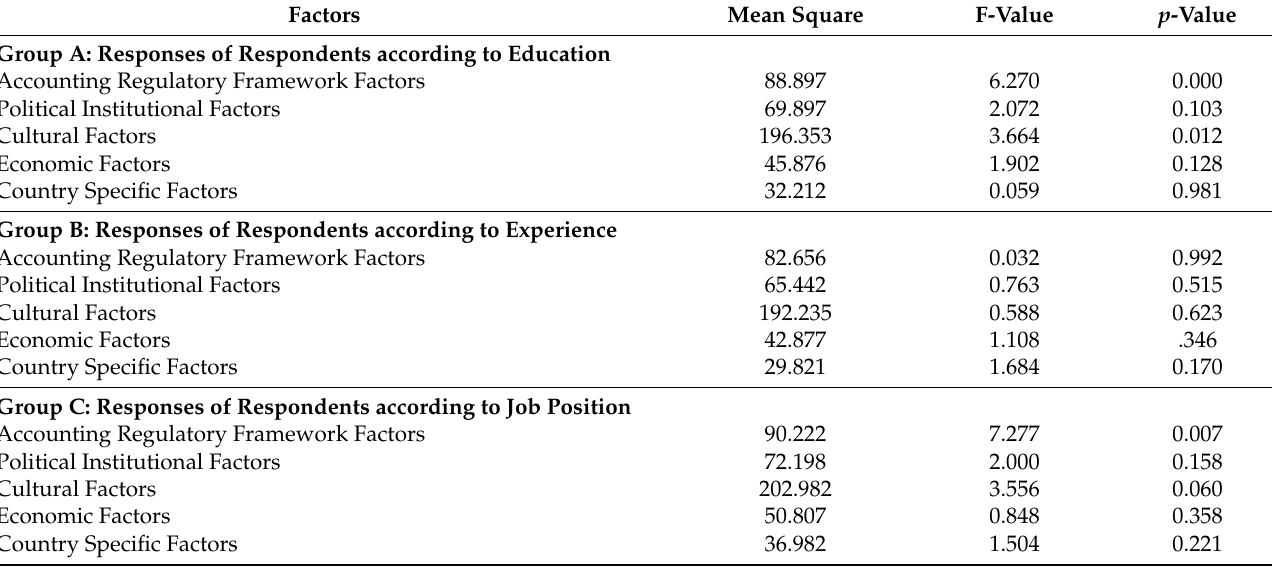
Table 9. One Way ANOVA Test.